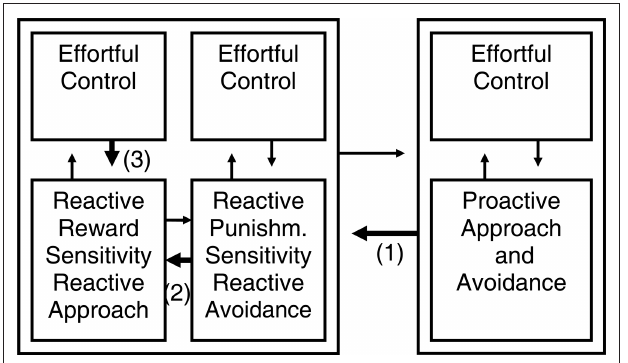
Figure 3 | Different kinds of self-regulation after adding effortful control to the temperamental influences. We introduced an “effortful control” element to each program from Figure 2 . Taking as example the self-regulation of reactive approach (i.e., impulsive reward responding), this model suggests that reactive emotional behavior can be regulated in at least three different ways: (1) by regulation from the proactive system; (2) by opposition from the other reactive system; (3) by effortful control (constraint) within the reactive system